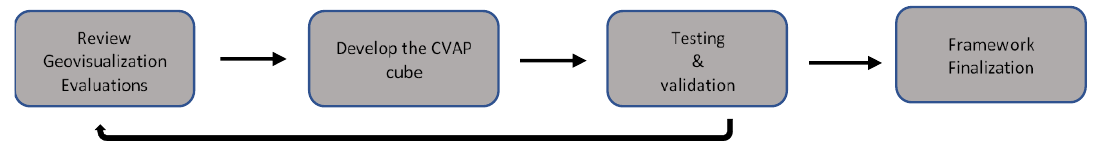
Figure 1. Methods workflow chart.